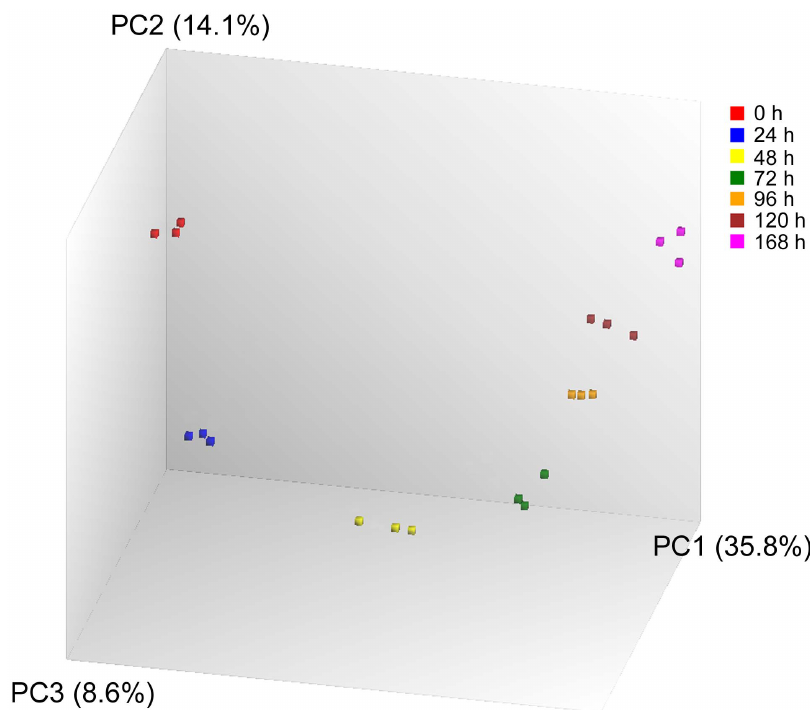
Figure 7. Principal component analysis (PCA) based on all (41,345) probesets in the array to cluster samples based on their similarities or dissimilarities in global gene expression level. The color codes for each time point are shown on the top right corner. The three axes PC1, PC2, and PC3 represent the first three principal components identified by the analysis. The percentage contribution of each component to the overall source of variation is included in the parentheses following each component name.